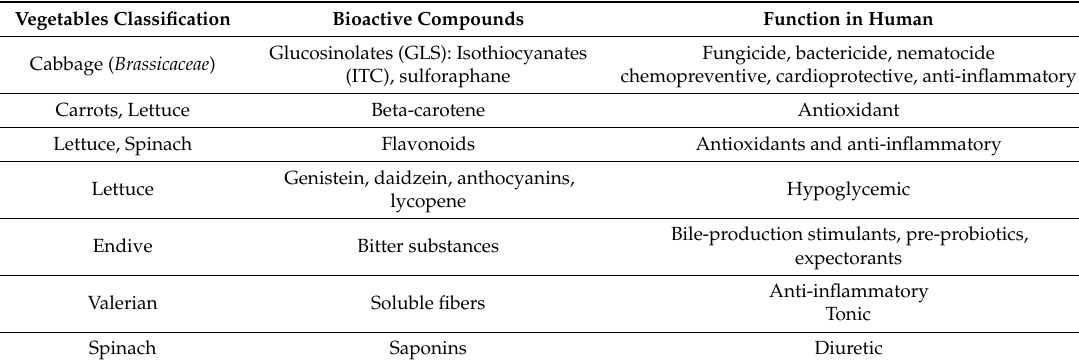
Table 4. Major bioactive compounds found in vegetables